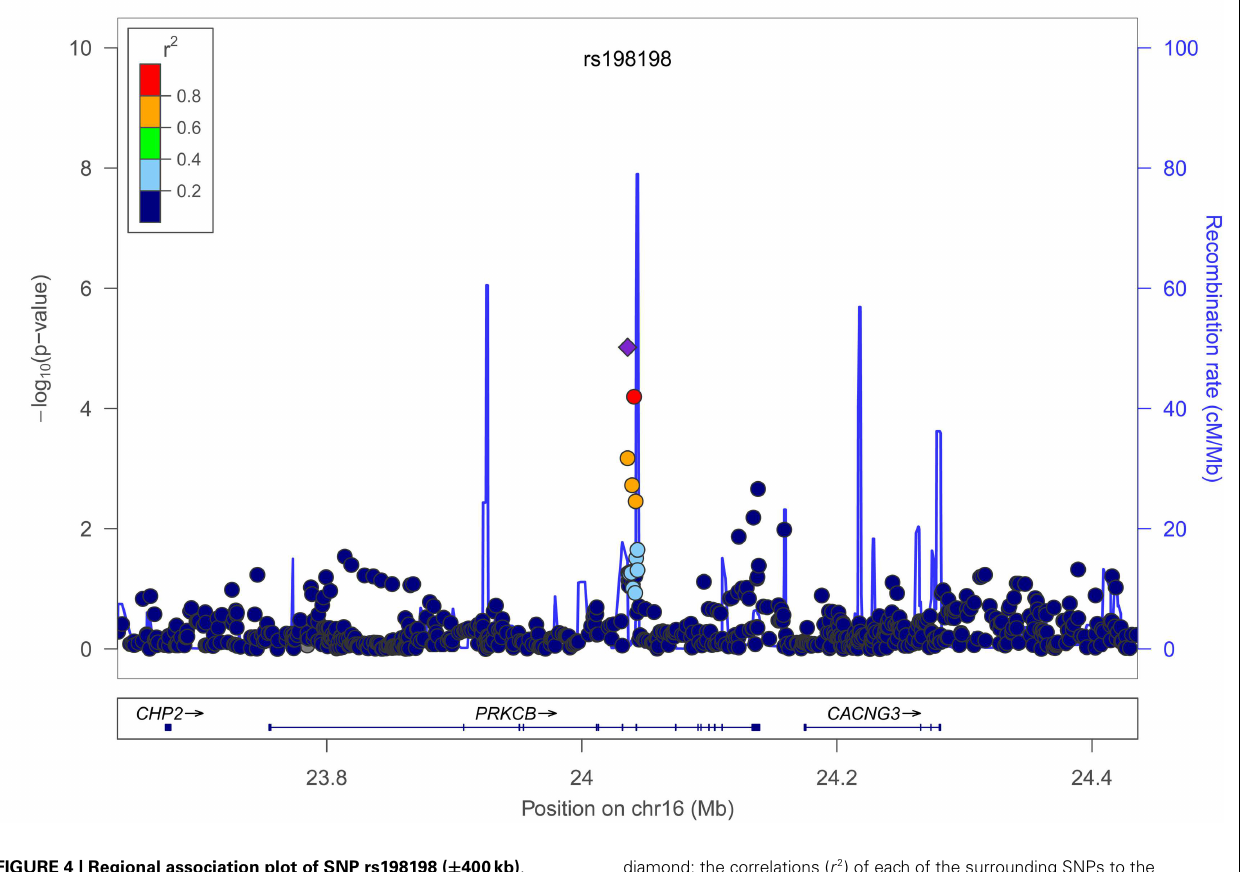
diamond; the correlations ( r 2 ) of each of the surrounding SNPs to the top SNP are shown in the indicated colors. Recombination rate is shown in pale blue.